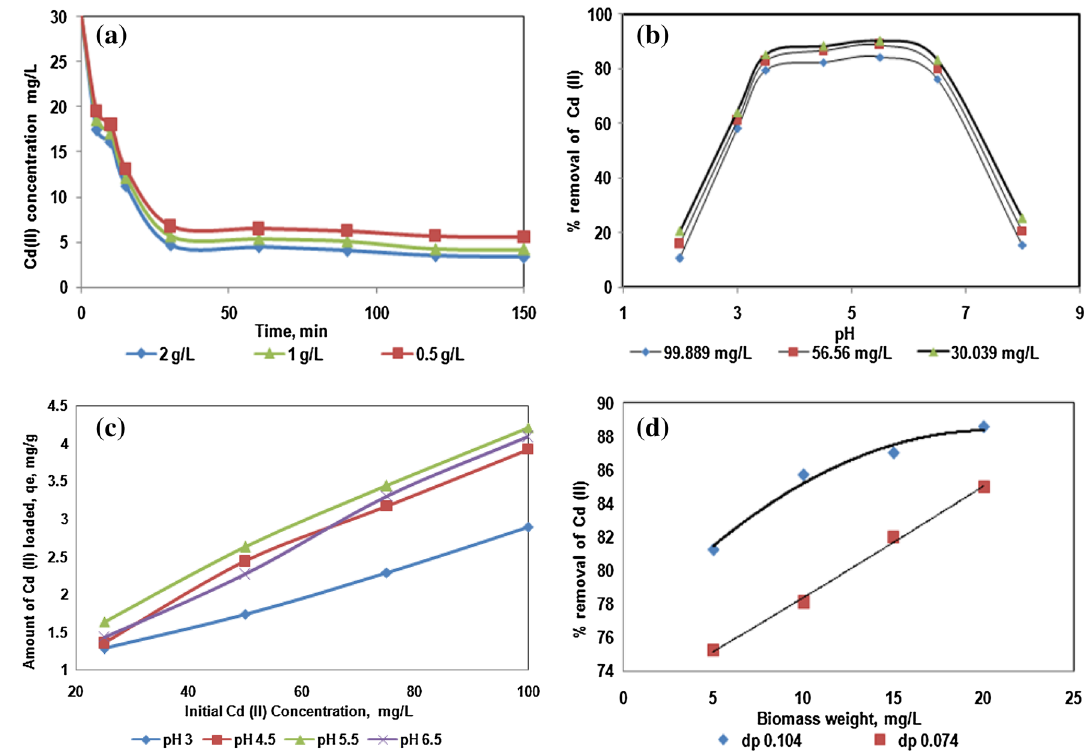
Fig. 1 Equilibrium time of A. heterophylla at 30 (cid:3) C, CT 30.039 mg L - 1 and pH 4.5 ( a ), effect of pH at temp. 30 (cid:3) C, dp 0.074 mm and biomass weight 20 g L - 1 ( b ), effect of initial metal